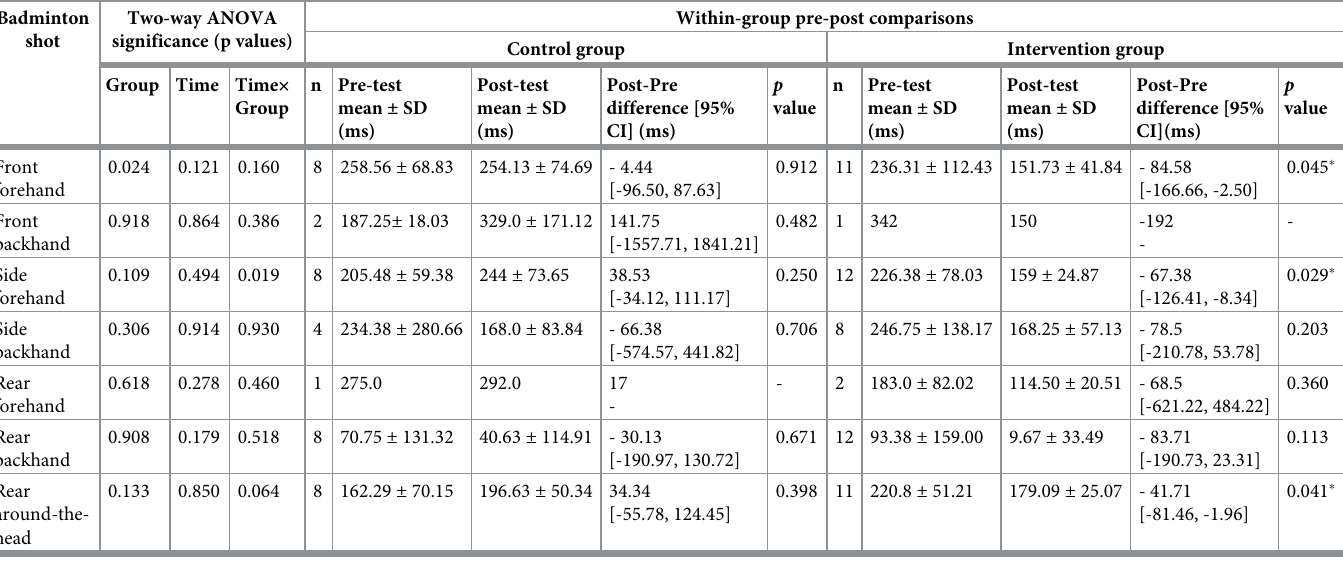
Table 3. ANOVA and paired comparisons of push-off times (in milliseconds) for seven badminton shots. Badminton Two-way ANOVA shot significance (p